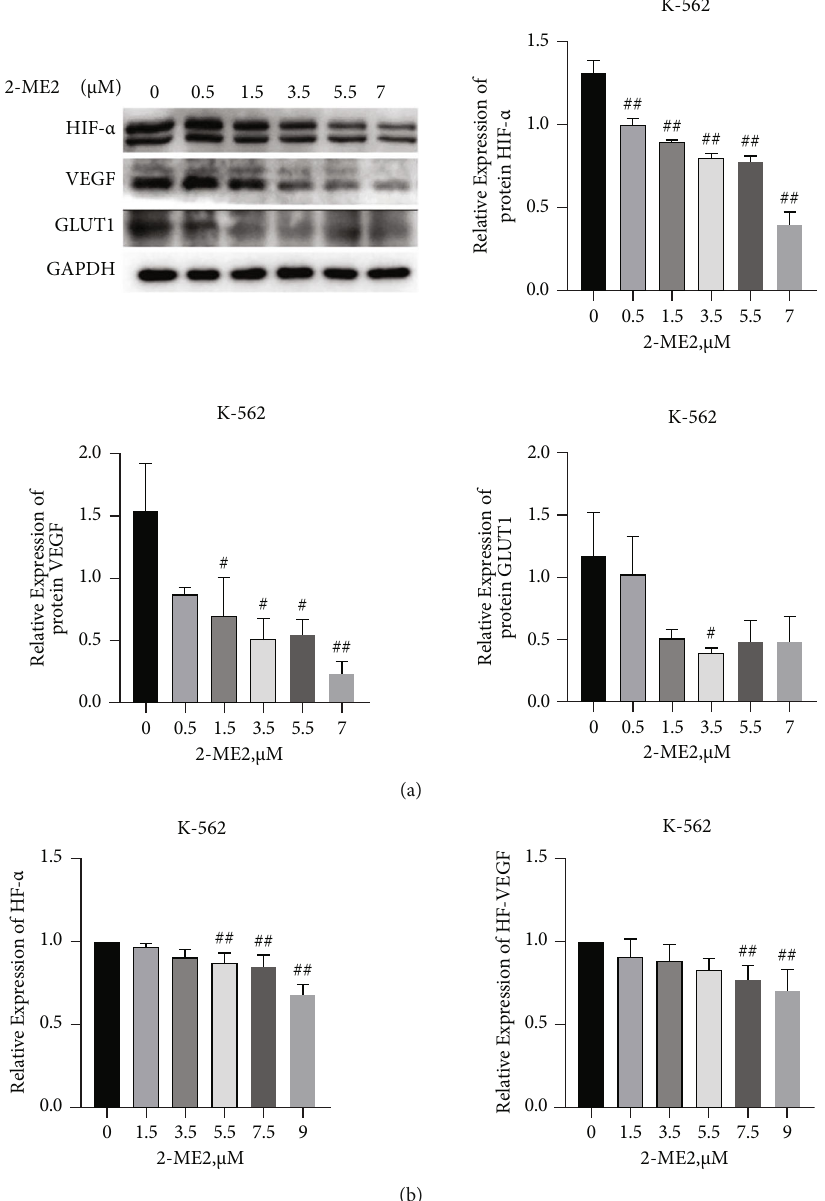
Figure 2: After 2-ME2 treatment of K-562 cells for 24h, the expression of downstream target genes was detected. (a) Western blot detection of HIF-1 α , VEGF, and GLUT1 protein expressions and gray values. (b) qPCR detection of the mRNA expressions of HIF-1 α and VEGF. Compared with control group, # P < 0 : 05 ; ## P < 0 : 01